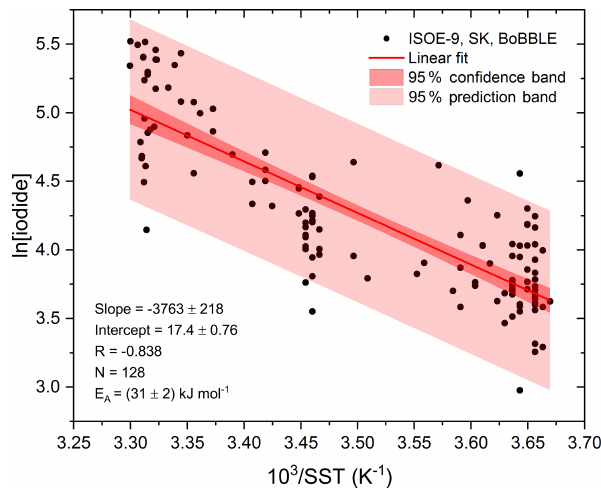
Figure 2. Arrhenius form plot of sea surface iodide concentrations against SST from all available seawater iodide field observations in the Indian Ocean and Southern Ocean. The red line represents a linear fit; the shaded region in dark red (inner) indicates the 95% confidence bands, and the shaded area in light red (outer) indicates the 95% prediction